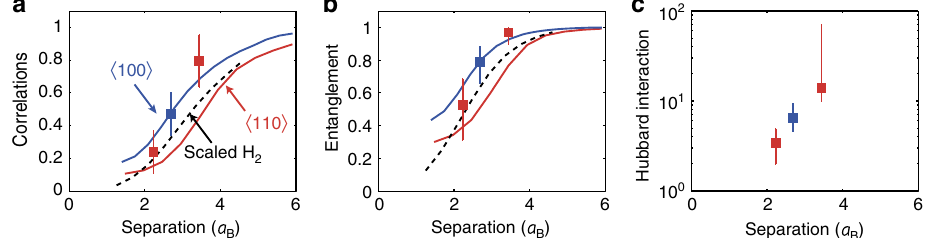
Figure 4 | Entanglement entropy and hubbard interactions. ( a ) Quantum correlations C versus d . Theory predictions are shown for coupled acceptors with h 110 i orientations (red line) and h 100 i (blue line), alongside scaled H 2 (dashed black line). Predicted localization is suppressed (enhanced) along h 110 i ( h 100 i ) relative to molecular hydrogen (H 2 ), due to valence band anisotropy, which enhances (suppresses) t . ( b ) Same as ( a ) for the entanglement entropy S . ( c ) Experimentally estimated Hubbard interactions. Error bars denote 95% confidence